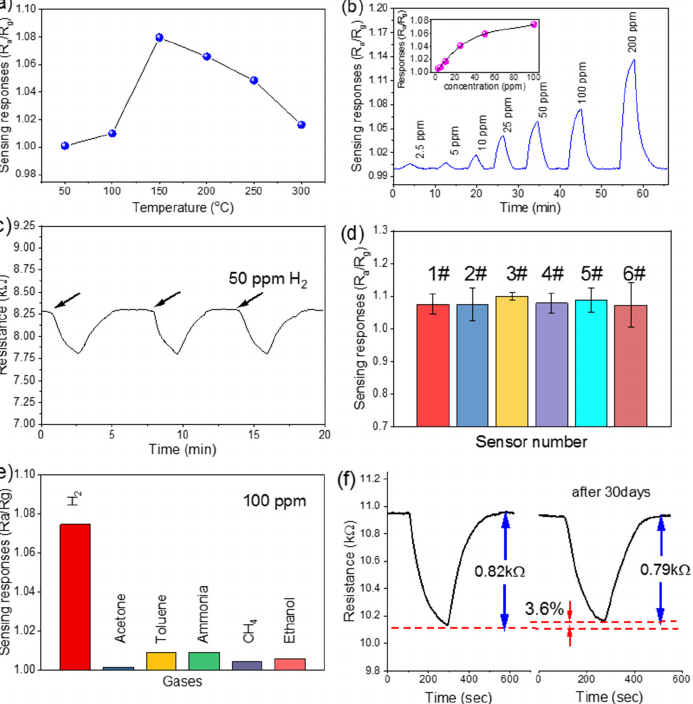
Figure 4. ( a ) Temperature ‐ dependent resistance change of the H 2 sensor, where the concentration of H 2 is 100 ppm. ( b ) Sensing responses to H 2 from 2.5 ppm to 200 ppm. Inset shows the relationship between the resistance change and gas concentration. ( c ) Repeatability test results of the H 2 sensor to 50 ppm H 2 at 150 °C. ( d ) Responses of six sensors (with serial numbers from 1# to 6#, prepared from different batches) to 100 ppm H 2 gas. ( e ) Selectivity of the Pd ‐ modified ZnO NWs sensor to five different gases. The concentration of all interfering gases is 100 ppm. ( f ) Long ‐ term stability test results of the sensor to 100 ppm H 2 gas. The interval between the two tests is 30